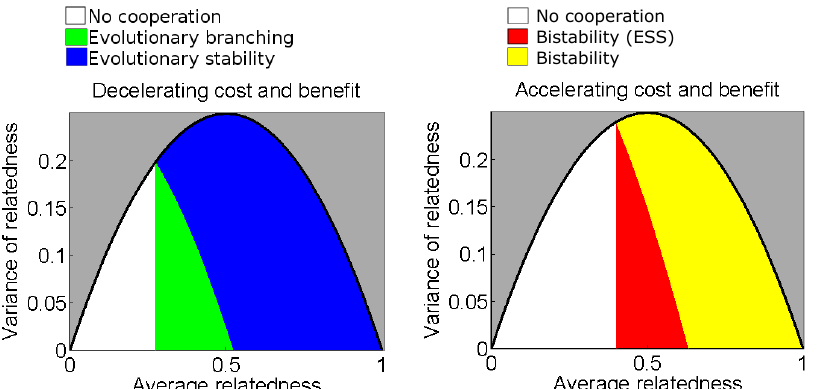
Figure 3. Plots of variance in relatedness against average relatedness. The grey region represents combinations of mean and variance that are not logically possible (see Appendix A.2). We see that for decreasing cost and benefit, the region with evolutionary branching shrinks with increased variance in relatedness. We also see that. for increasing cost and benefit, the region with neither convergence stability nor evolutionary stability shrinks with increased variance in relatedness. In the latter case, with increased average relatedness or variance in relatedness, the singular strategy moves from evolutionary stability (ESS) without convergence stability to neither evolutionary stability nor convergence stability. The parameters used are in both cases N = 10, and b 1 , b 2 , c 1 , c 2 as in Figure